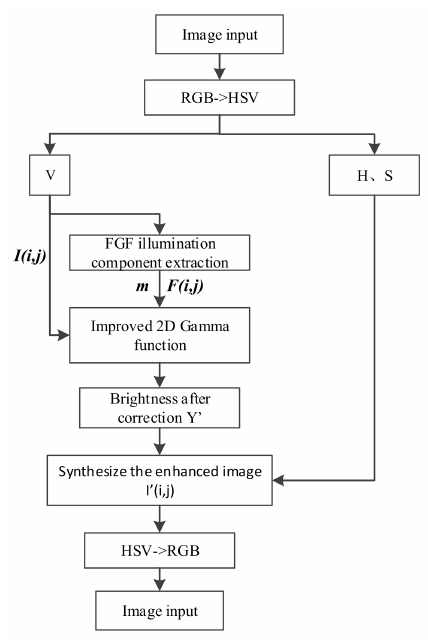
Figure 1. Image preprocessing